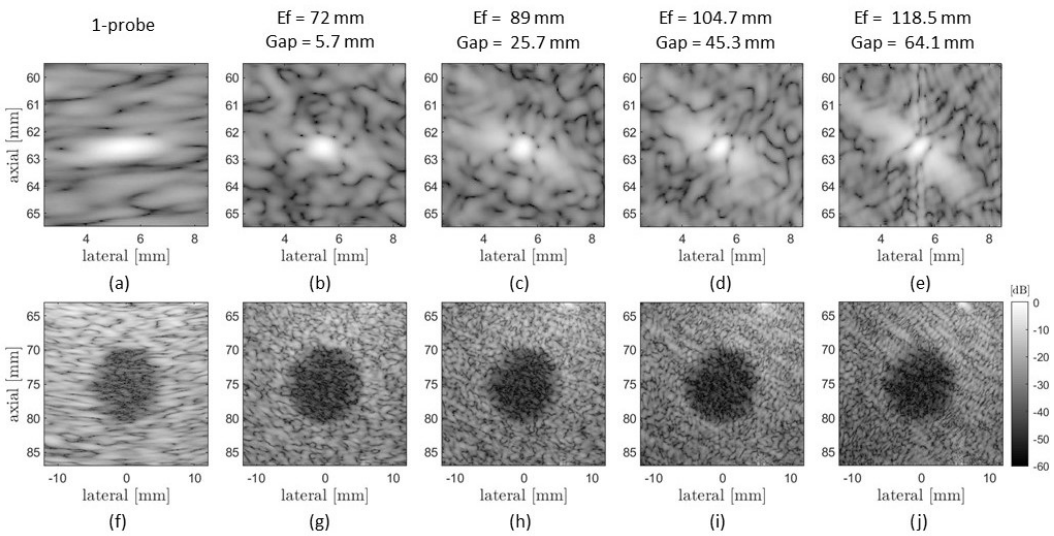
Figure 5. Simulated point targets (upper row) and lesion images (lower row) of the control medium obtained by one probe ( a , f ) and CoMTUS ( b – e , g – j ) with different effective apertures (Ef) and gaps between the two arrays